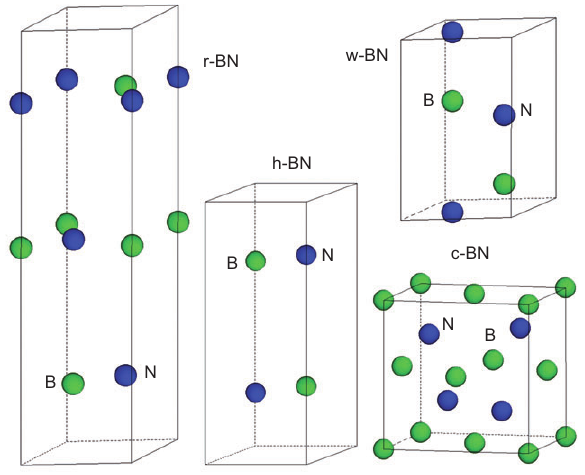
Figure 25 Structure models of r-BN, h-BN, c-BN, and